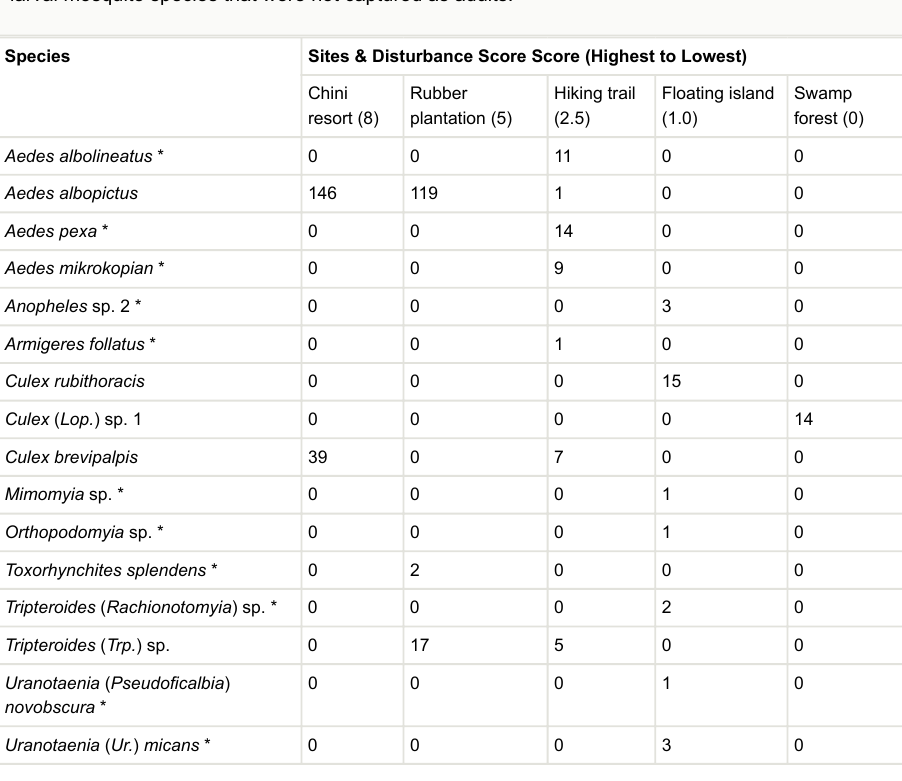
Larval mosquito species were sampled across five sites with different disturbance scores (bracketed). A sampling focal point was chosen at each site and larvae mosquitoes within the 100- m radius of the focal point were collected from both natural and artificial containers. '*' denotes larval mosquito species that were not captured as